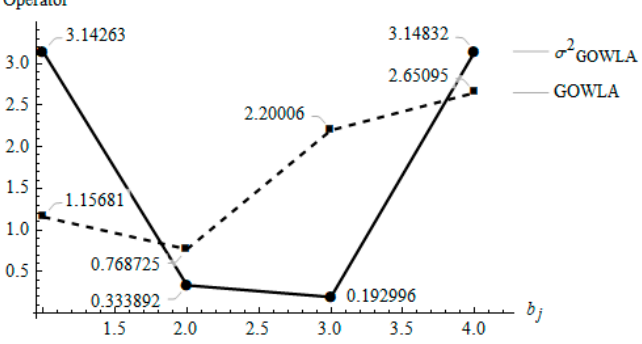
Figure 2. GOWLA and σ 2 GOWLA operators following the conditions in Example 1. The 𝜎 (cid:2870) (cid:2891)(cid:2899)(cid:2907)(cid:2896)(cid:2885) operator and its extensions share the basic property of commutativity with the OWA and the GOWLA operators, i.e., f is the 𝜎 (cid:2870) (cid:2891)(cid:2899)(cid:2907)(cid:2896)(cid:2885) operator and 𝑏 (cid:3041) is any permutation of 𝑎 (cid:3041) , then 𝑓(𝑎 (cid:3036) , … , 𝑎 (cid:3041) ) = 𝑓(𝑏 (cid:3036) , … , 𝑏 (cid:3041) ) ; however, due to the inherent charac-